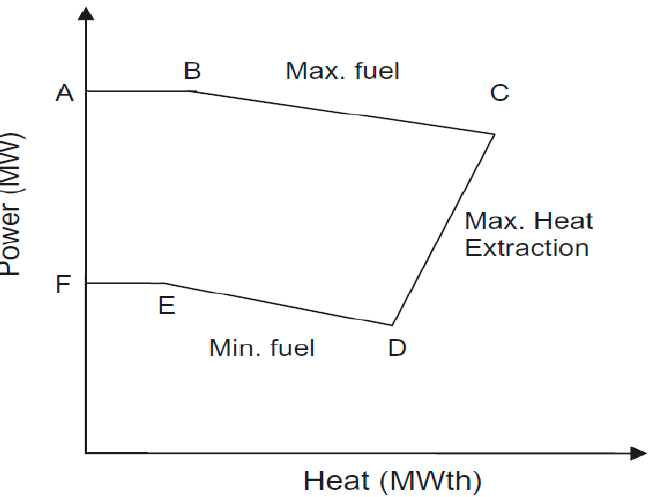
Figure 10. Heat-power feasible operation region for a CHP unit, considered for the CHPEED prob- lem